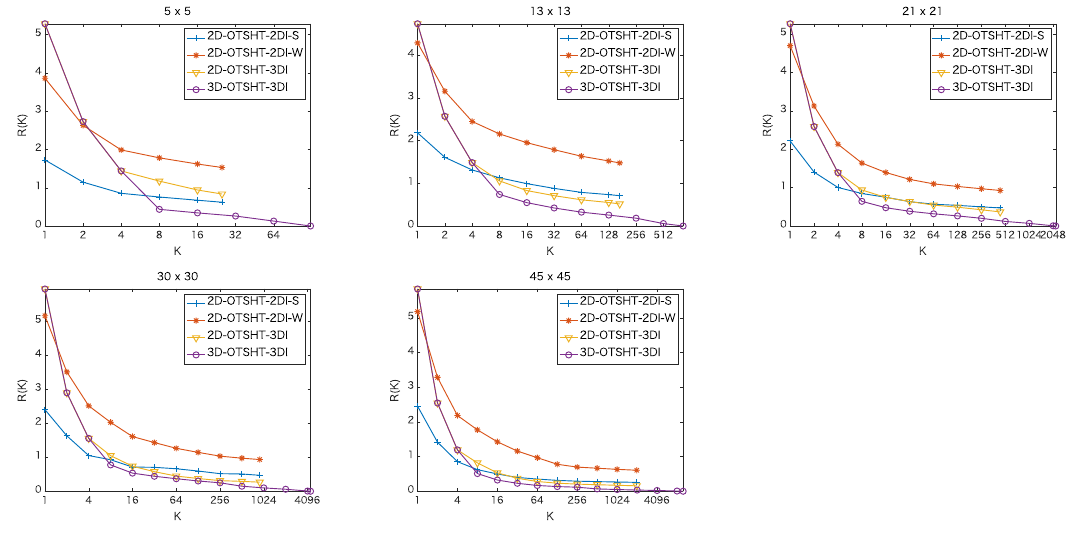
Figure 5. Percentage of extra patches remaining at K basis images/blocks in 5-band images of size 1824 ×